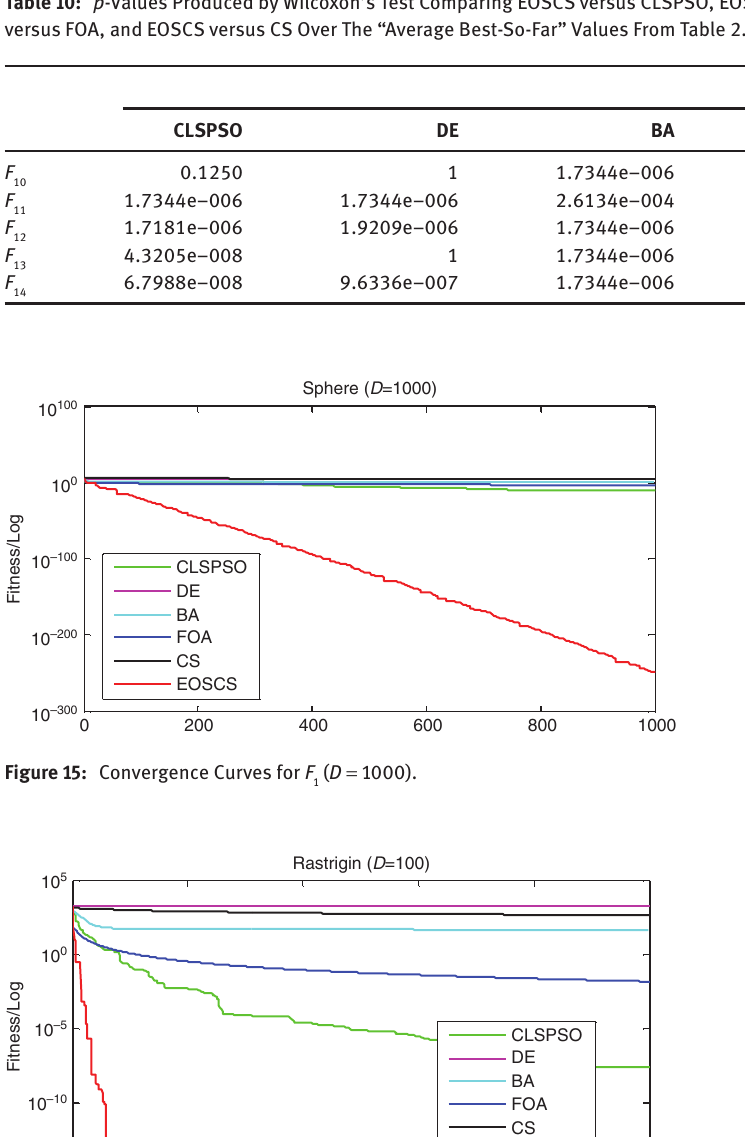
Figure 16: Convergence Curves for F